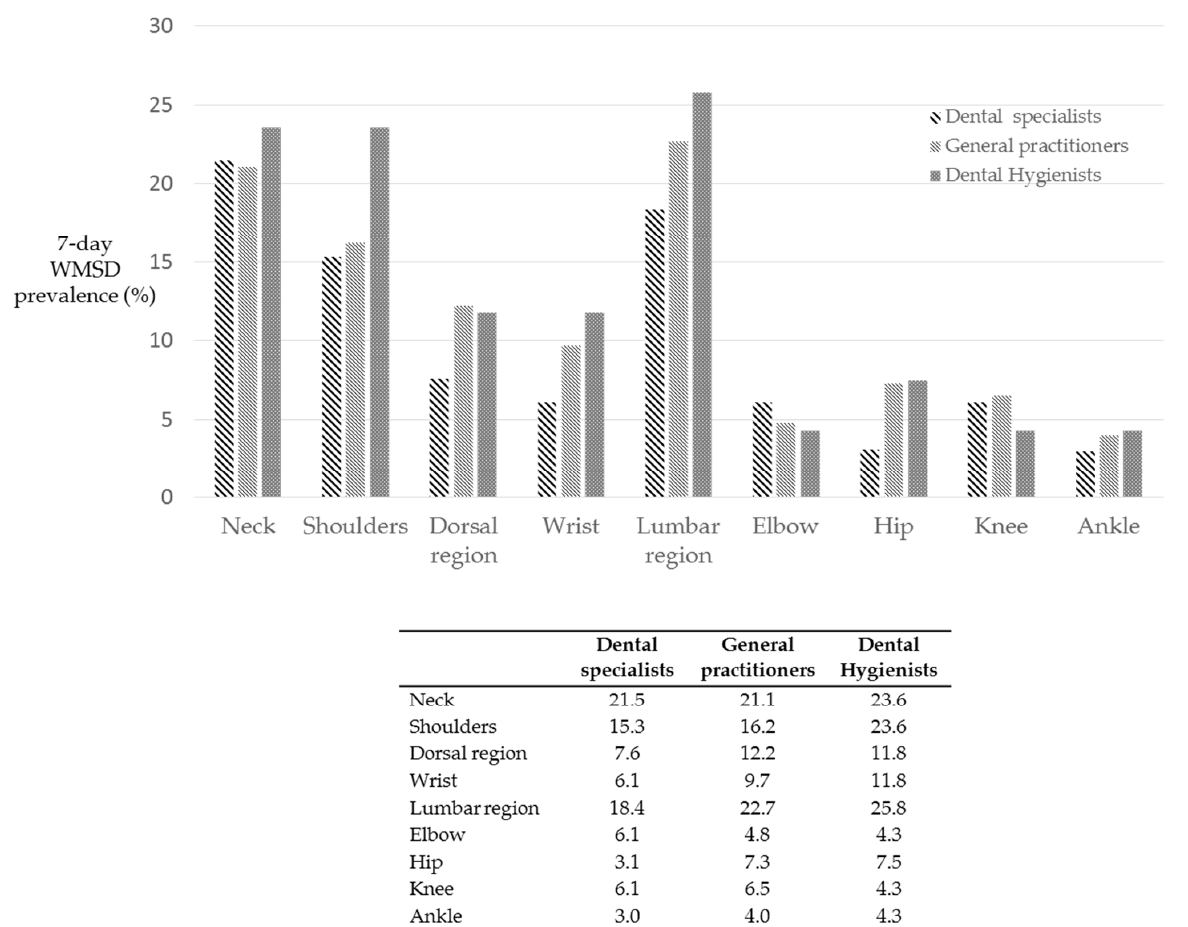
Figure 7. Distribution of WMSD experienced in the last 7 days by 284 surveyed dental professionals. Neck, shoulder and lumbar region were the most affected areas, involved in approximately 20% of the operators. No significant differences were observed when considering dental occupation ( p > 0.05).